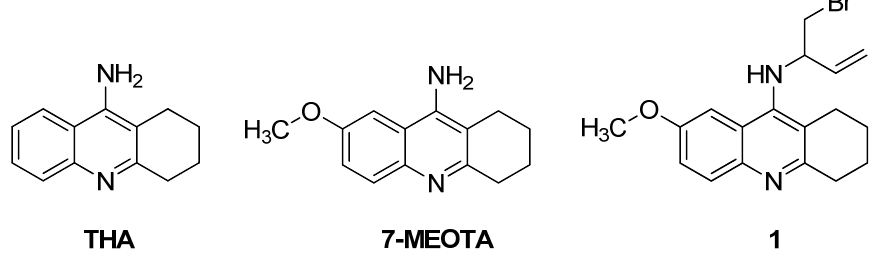
Figure 1. Structures of THA, 7-MEOTA and analogue 1